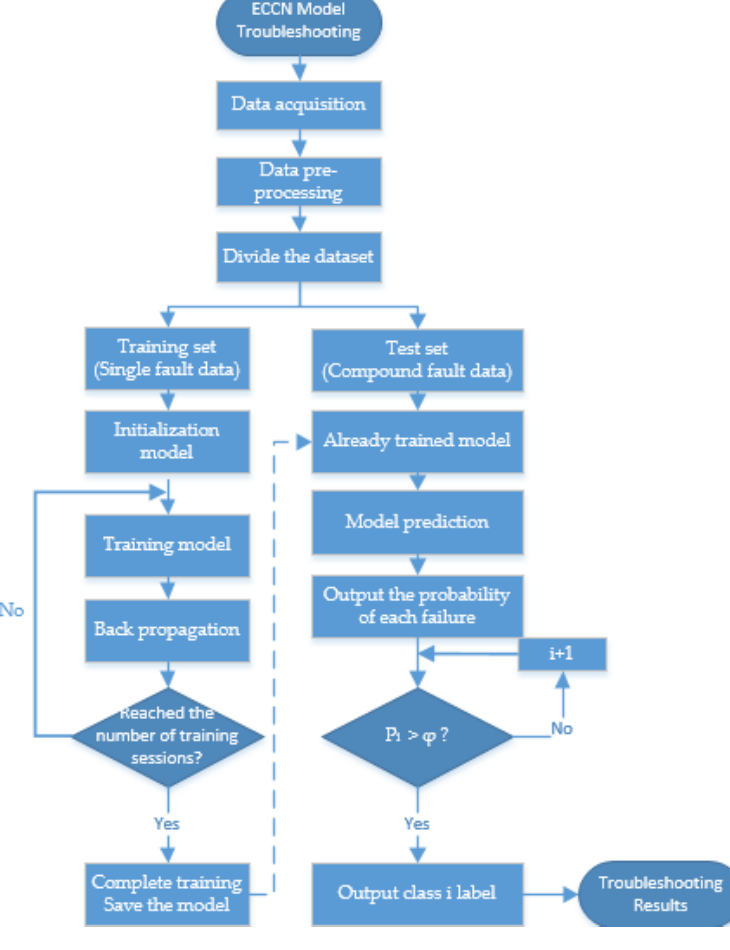
Figure 7. Fault diagnosis flowchart of ECCN model.